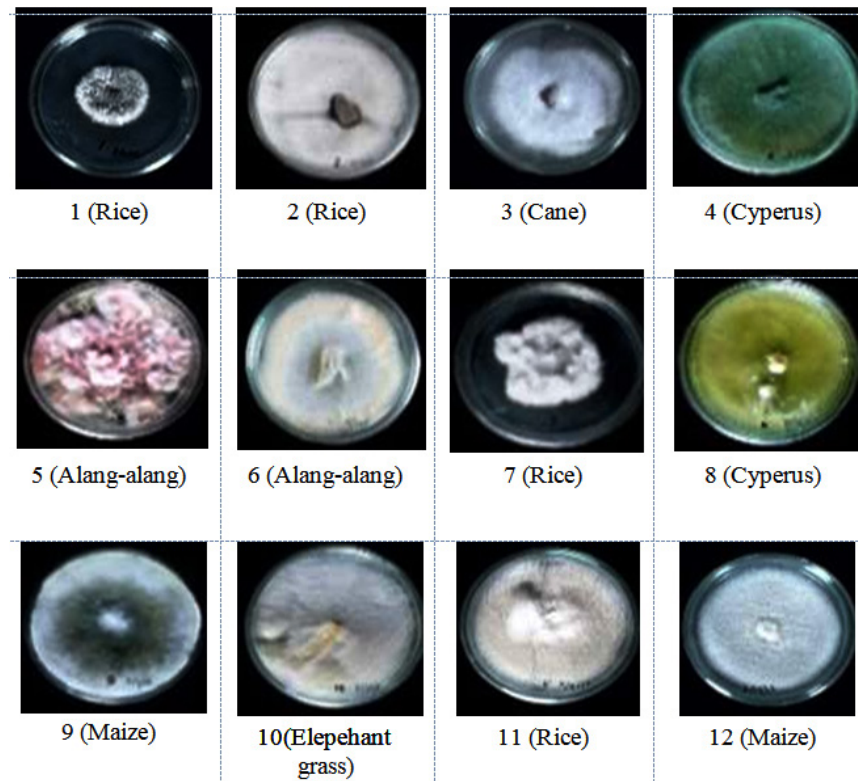
Fig. 1. Positive isolates on rice seed germination and seedling growth with morphological